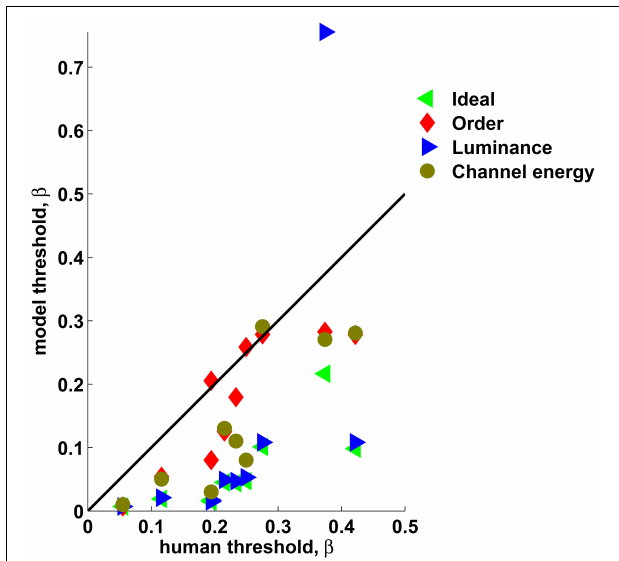
FIGURE 6 | The theoretical observers’ thresholds vs. the human observers’ thresholds. The black line represents identity. All texture sets are combined. It can be seen that the Order observers’ thresholds (red diamonds) approach those of the human observers and the Channel energy observers (brown circles) often approach those of the Order observers, whereas Ideal (green left triangles) and Luminance (blue right triangles) outperform the humans, except for the Luminance observer applied to Texture set 1.